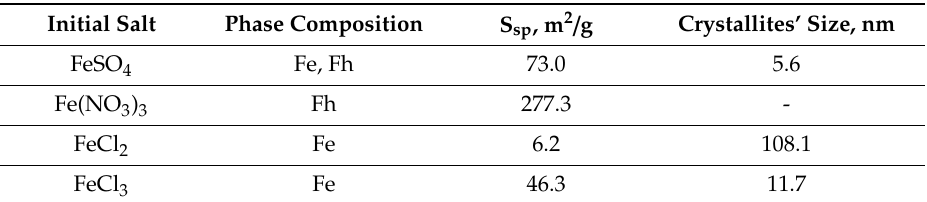
Table 1. The characteristics of the recovered